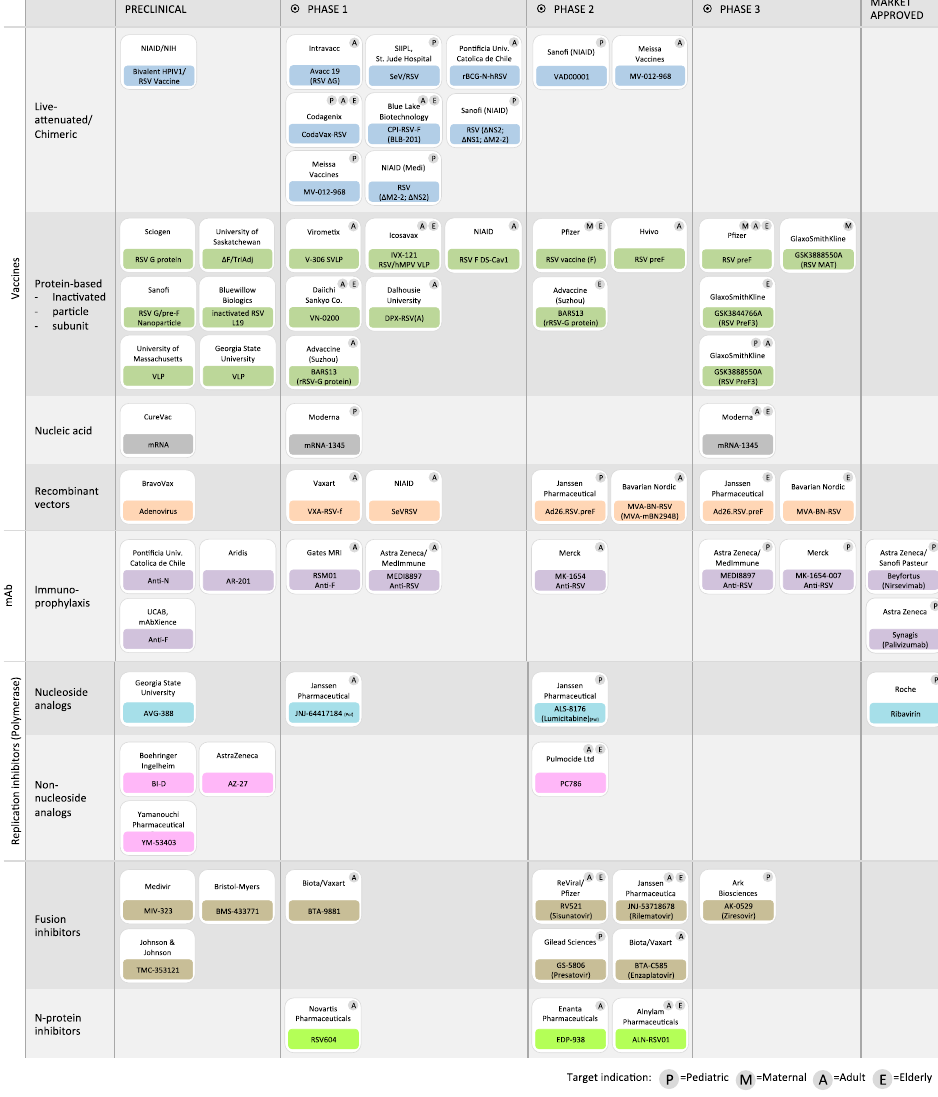
Figure 8. Snapshot of the development of RSV clinical interventions. Adapted from the PATH website at www.path.org (accessed date 9 January 2023) and